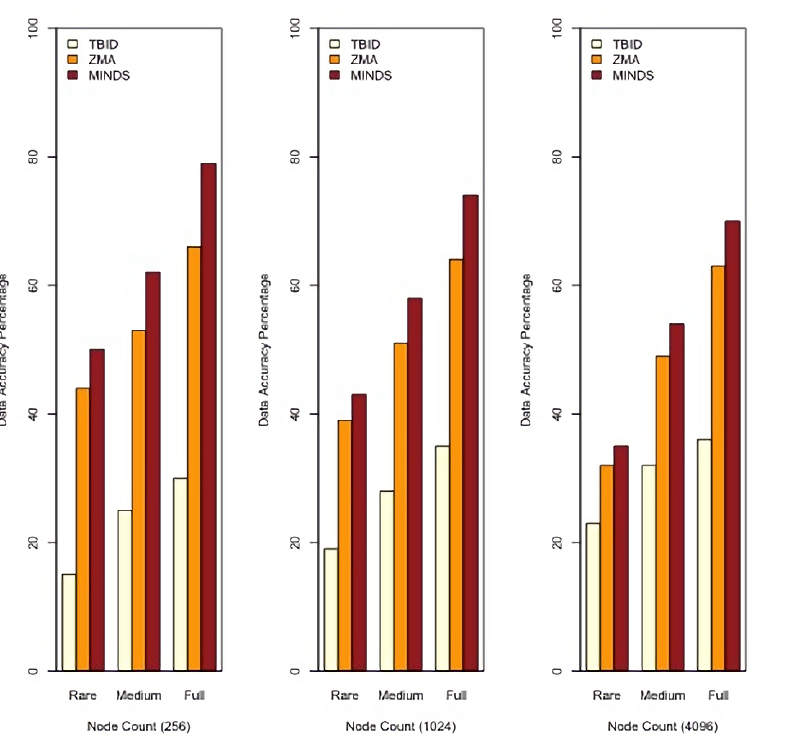
Figure 6. Data robustness